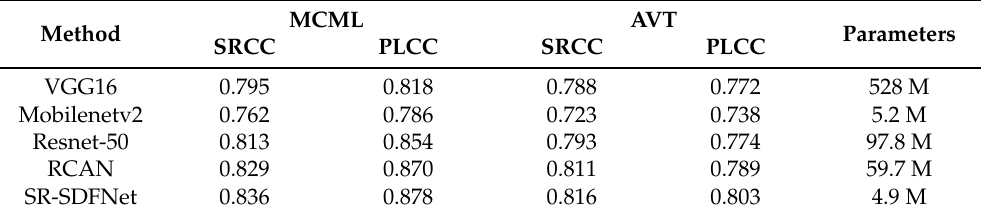
Table 4. Performance comparison of different spatial feature extractors on two databases.